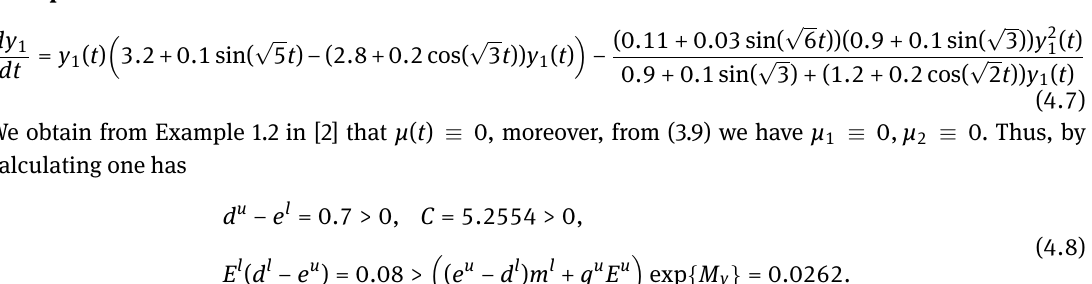
( t ) of system (4.7) with the initial conditions y * 1